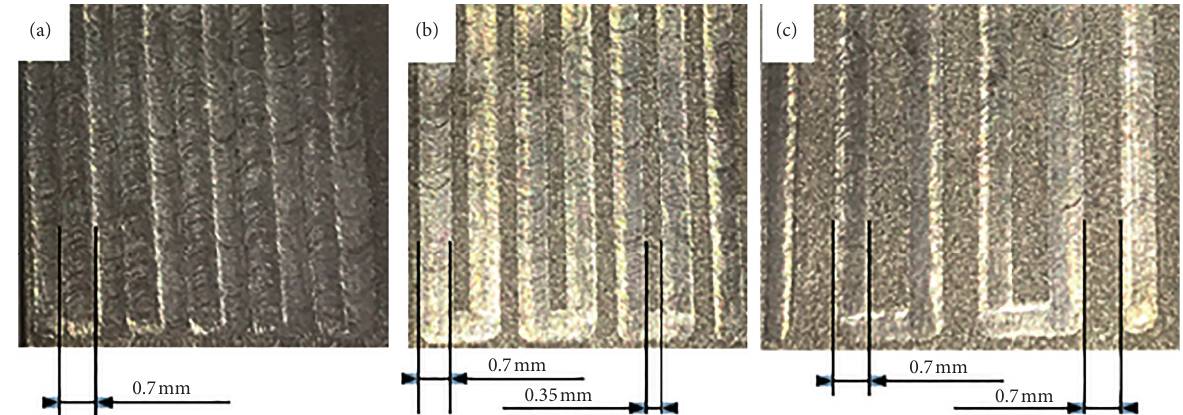
Figure 5: General view of laser-treated area. (a) Case B. (b) Case C. (c) Case D.